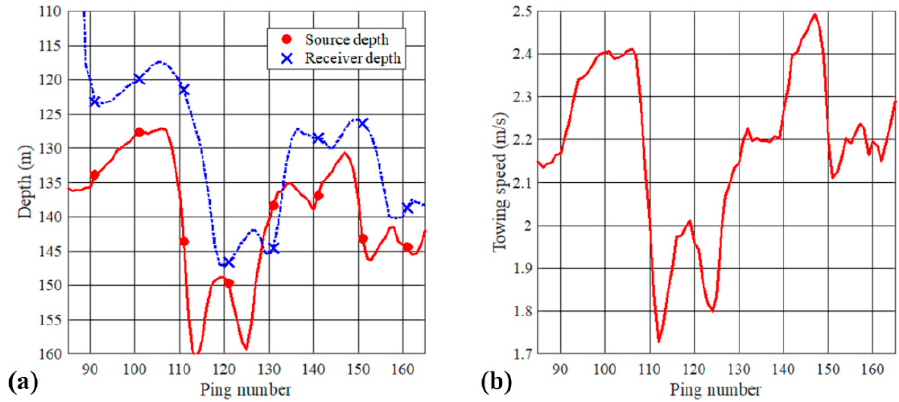
Figure 4. ( a ) Source and receiver depth for ping number. ( b ) Towing speed for ping number.